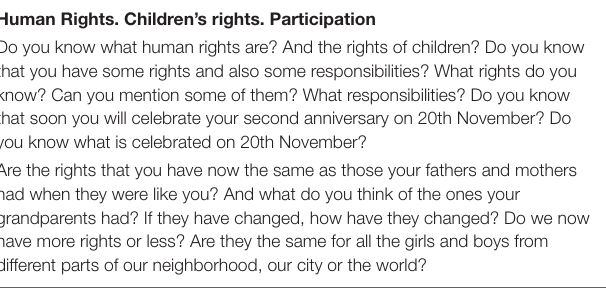
TABLE 2 | Semi-structured group interview